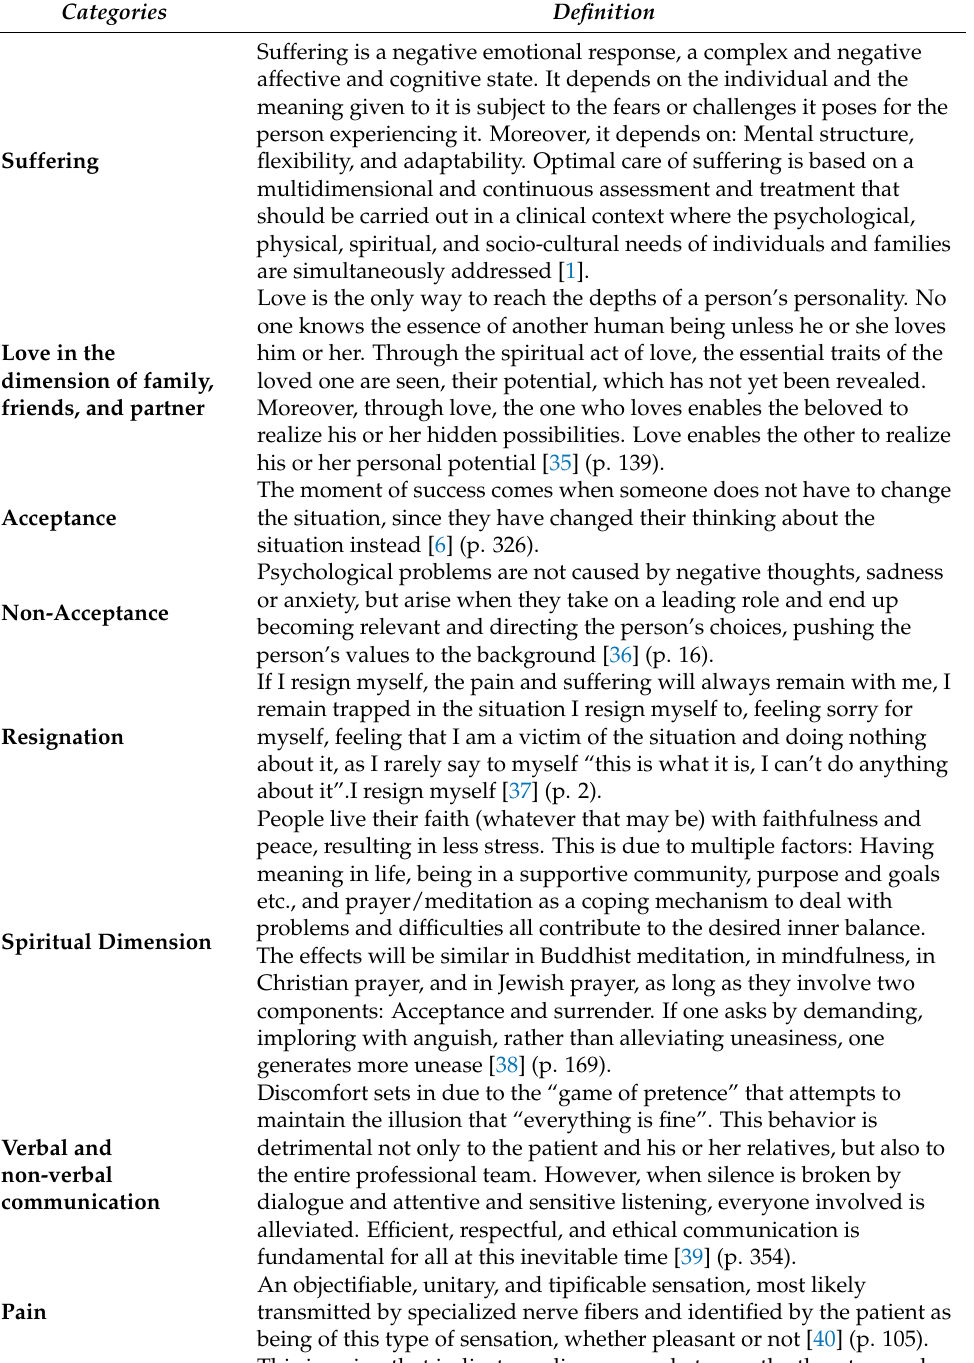
Table 4. Categories that make up the instrument and their operational